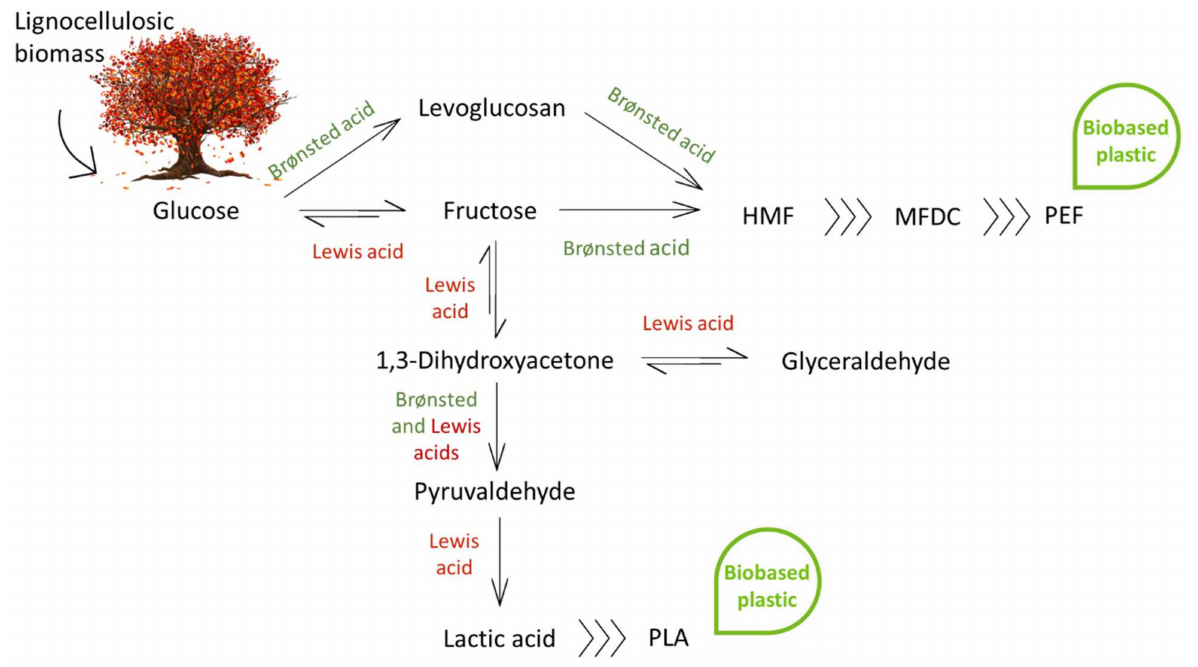
Figure 1. Brønsted/Lewis acid-catalyzed conversion of glucose to HMF and lactic